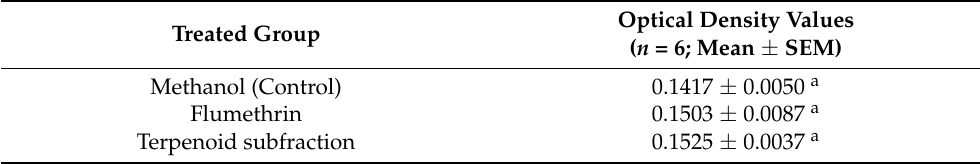
Optical Density